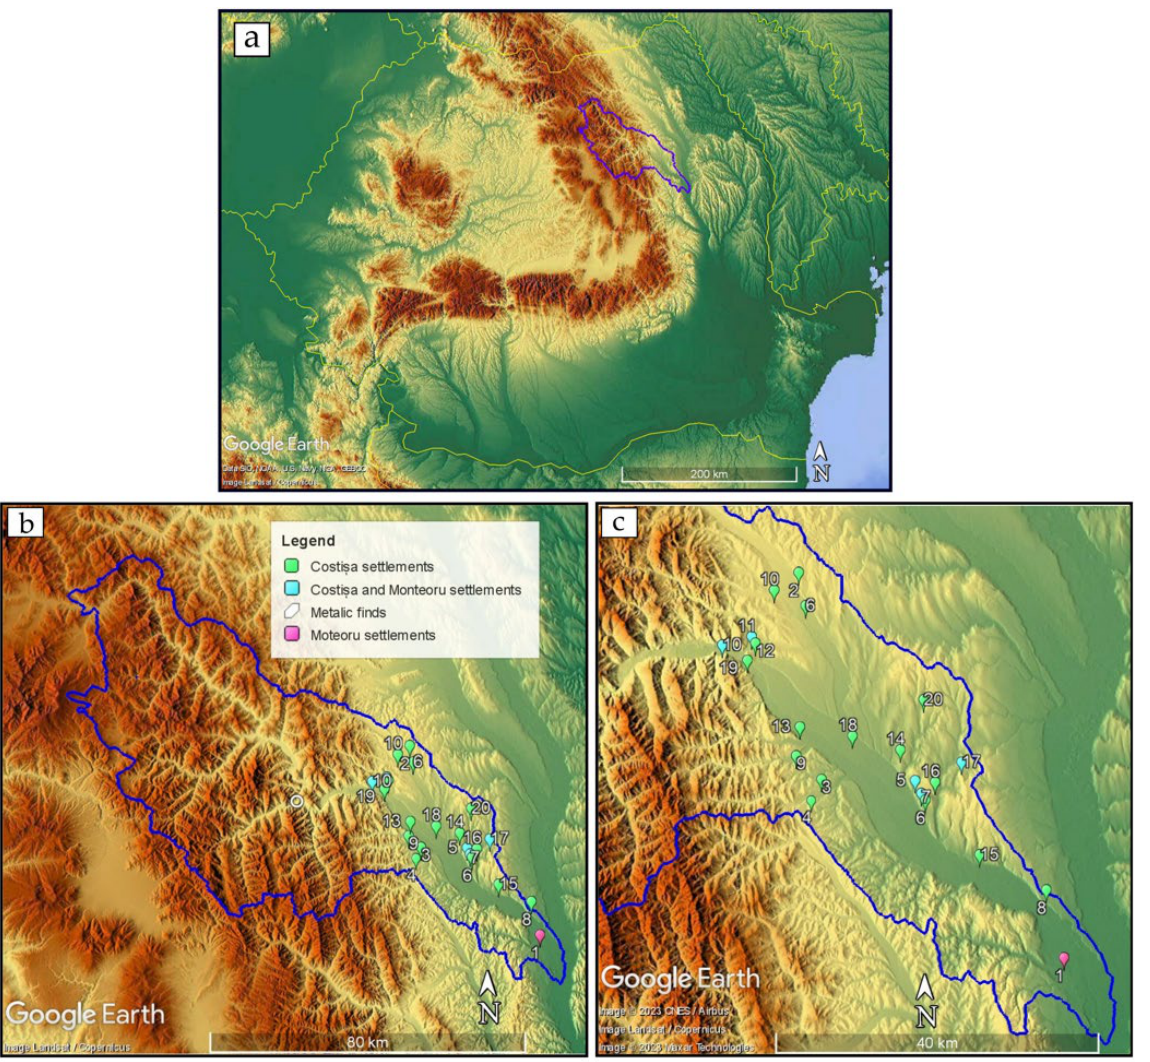
Figure 1. Bistrița River basin: ( a ) localization on Romanian territory; ( b ) discoveries specific to the Middle Bronze Age; ( c ) Costișa and Monteoru sites (1. Bacău — Mărgineni ; 2. Bodeștii de Jos— Cetățuia Frumușica ; 3. Borlești — Dealul Cucului/Dealul Nucului ; 4. Borlești — Dealul Runcu ; 5. Costișa — Dealul Bisericii/Piciorul Moenii ; 6. Costișa — Dealul Stanciului ; 7. Costișa — Cetățuia ; 8. Itești — Lac Lilieci ; 9. Luminiș — Deleni ; 10. Piatra- Neamț — Bâtca Doamnei ; 11. Piatra- Neamț — Lutărie ; 12. Piatra- Neamț — Pietricica ; 13. Piatra Șoimului — Horodiștea/Capul Dealului ; 14. Podoleni— Dealul Teiului ; 15. Racova; 16. Siliștea — Vatra Satului ; 17. Siliștea — Pe Cetățuie ; 18. Traian— Dealul Fântânilor ; 19. Văleni — Cetățuia ; 20 Ho isești — La Curmătură 1 ).